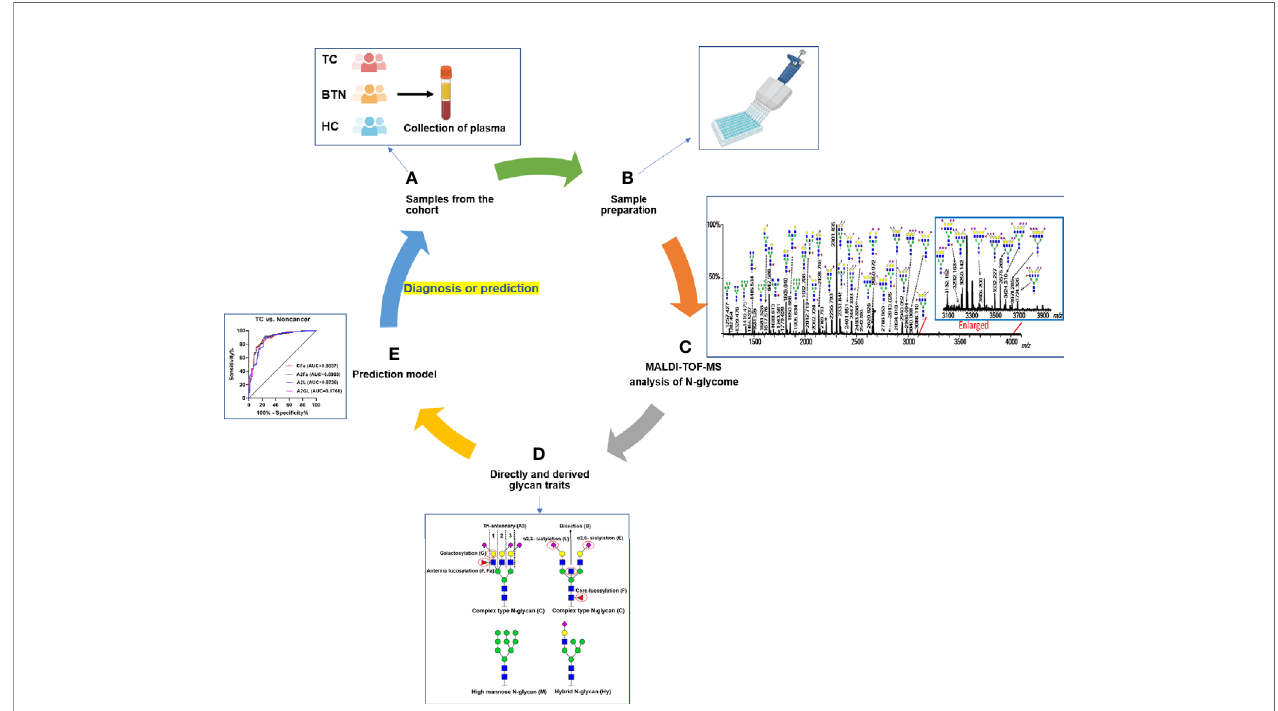
FIGURE 1 | Work fl ow of plasma N -glycome analysis of TC, BTN, and HC. (A) Collection of plasma samples from diseases and controls; (B) High-throughput sample preparation including glycan release, derivatization, and enrichment; (C) MALDI-TOF-MS analysis of plasma N -glycome and data preprocessing and annotation; (D) Calculation of derived glycan traits; (E) Construction of prediction models and ROC curve analysis to test their performance. TC, thyroid cancer; BTN, benign thyroid nodules; HC, healthy